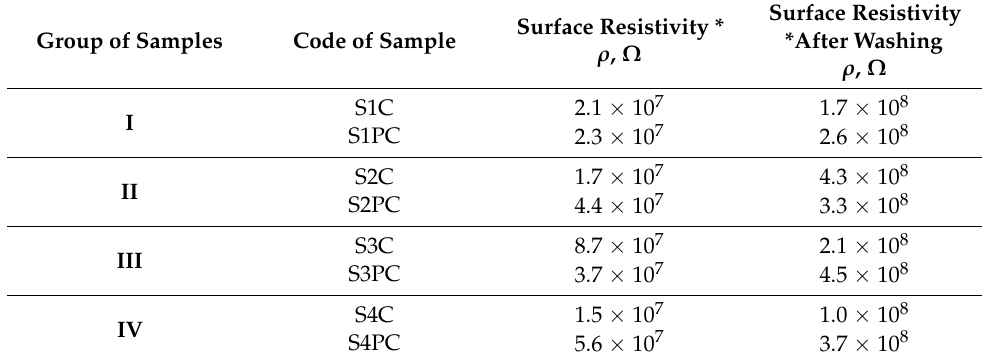
Table 4. The electrostatic properties of investigated fabrics.